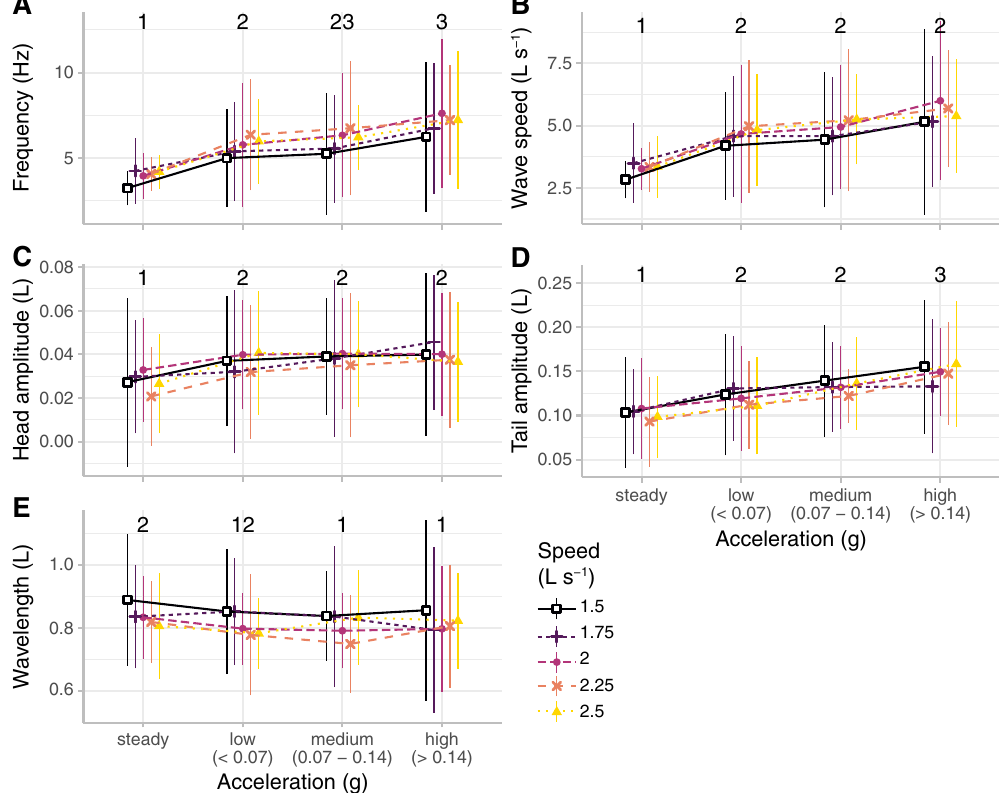
Figure 2. Bluegill sunfish ( N = 5) altered swimming kinematics as acceleration increased. The plots show the relationship of acceleration and swimming speed with ( A ) tail beat frequency, ( B ) body wave speed, ( C ) head amplitude, ( D ) tail amplitude, ( E ) body wavelength, and ( F ) maximum muscle strain. Colour indicates the flow tank speed. Acceleration groups labelled with different numbers are significantly different from one another (p < 0.01). See Table S1 for statistical